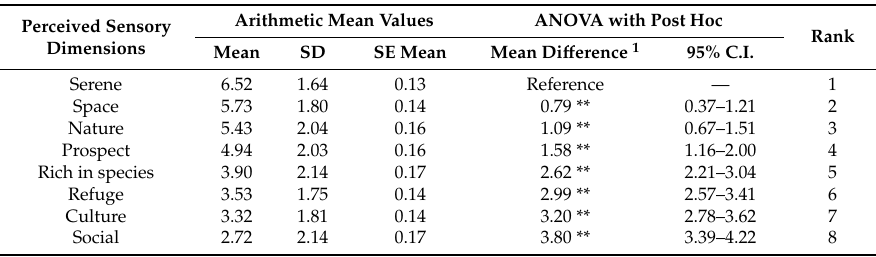
Table 3. Arithmetic mean value and post hoc tests in ANOVA concerning the preferences of respondents in highest stress group for eight sensory dimensions (N = 163).